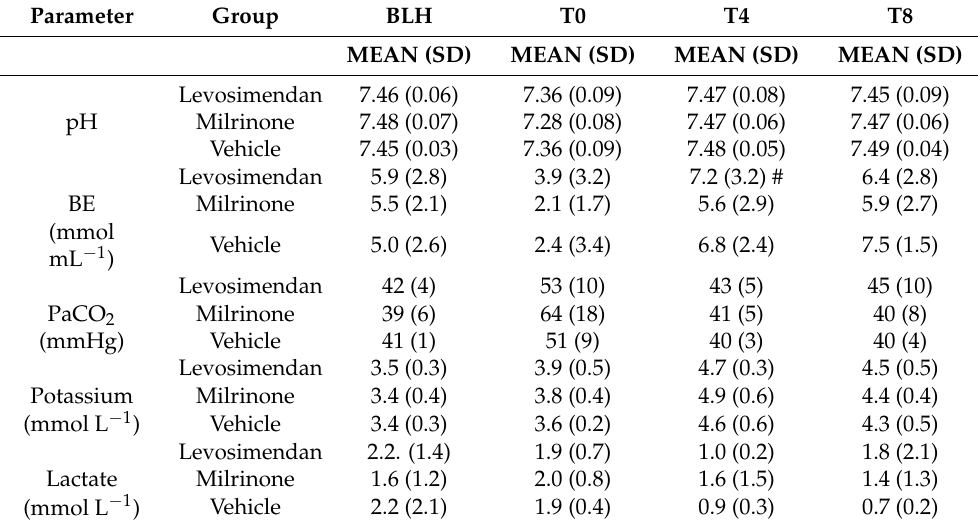
Table 4. Blood gas analysis. Values are mean (SD). BE: base excess; PaCO 2 : arterial carbon dioxide; BLH: baseline healthy. # indicates p < 0.05 in intergroup